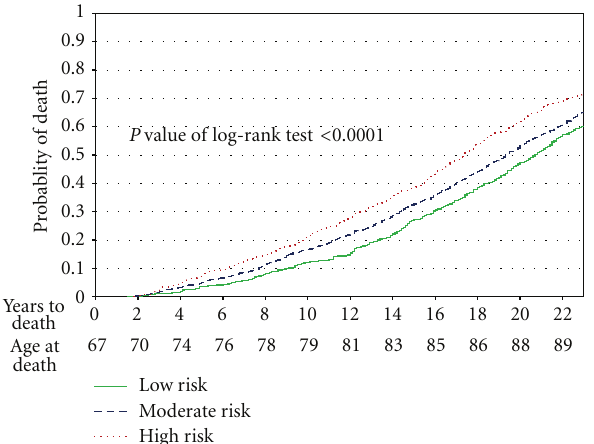
Figure 4: Kaplan-Meier analysis, University of Pennsylvania 1986–